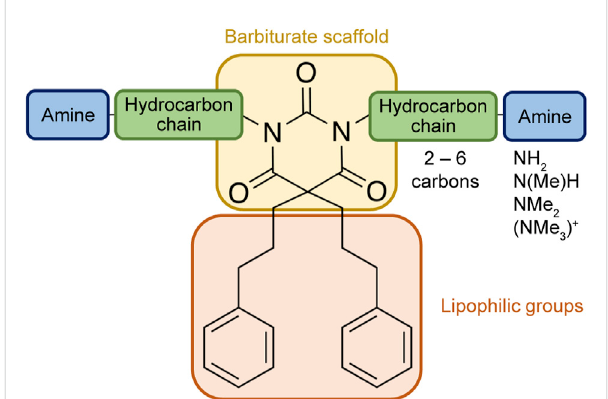
FIGURE 1 Generalstructureofthemarineproductmimics(MPMs)included in this study. All compounds share the same barbiturate scaffold and lipophilic groups. All compounds also have two identical